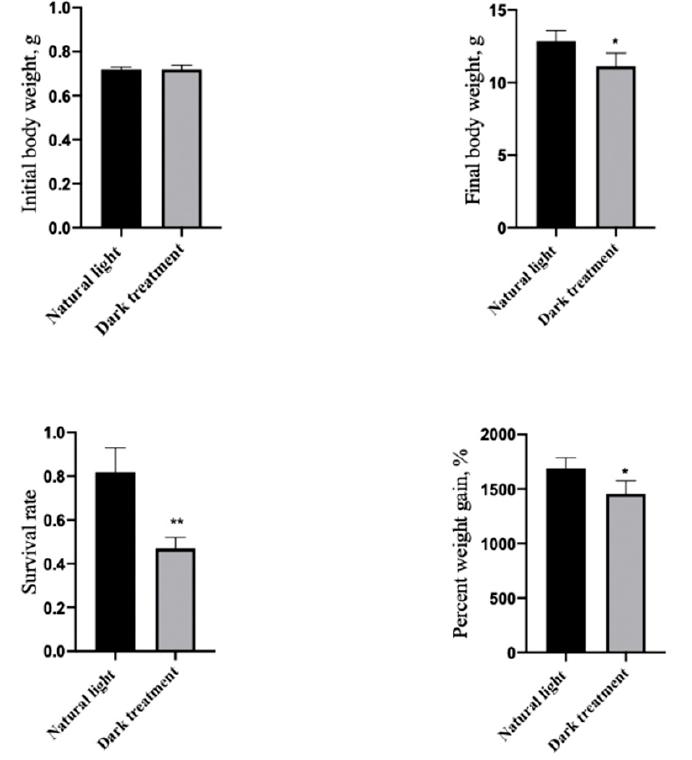
Figure 5. Effects of dark treatment on growth performance in L. vannamei. Values are represented as mean ± SD (n = 4) by vertical bars. Bars assigned with asterisks are significantly different (* indicates p < 0.05, ** indicates p < 0.01).